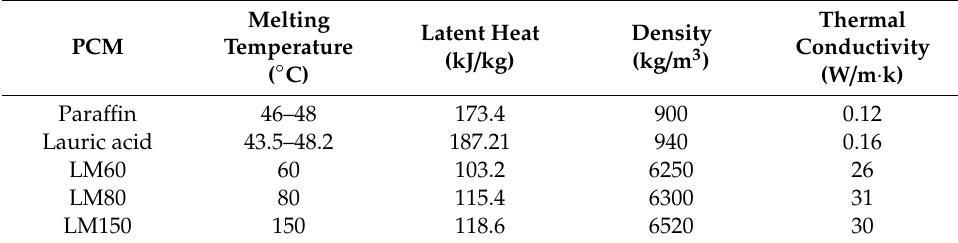
Table 1. The specific parameters of phase change material (PCM).